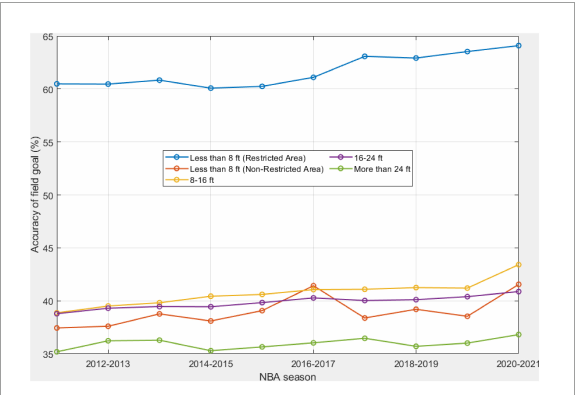
FIGURE4 Changes in the accuracy of field goals from each of the five shooting distances in the past decade.